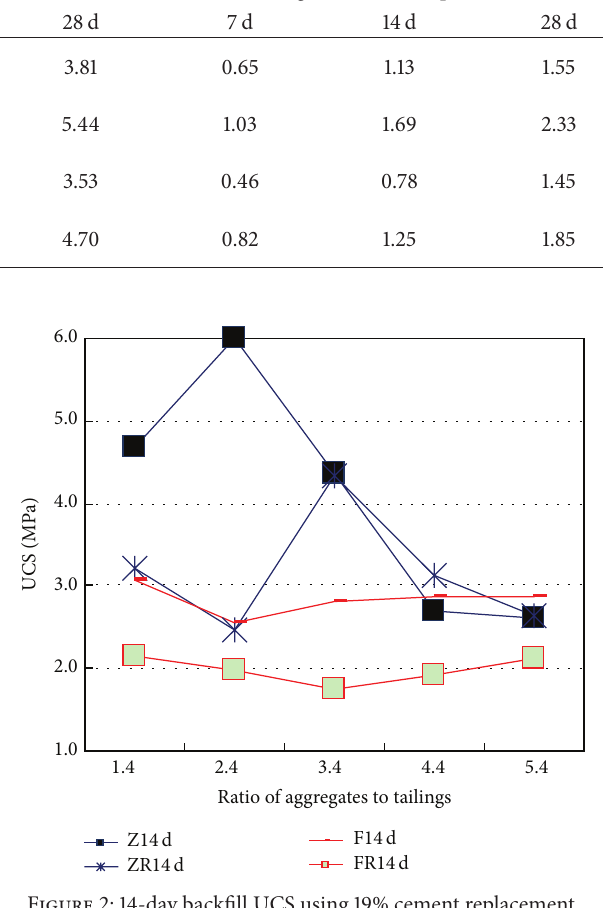
Figure 1: 7-day backfill UCS using 19% cement replacement. Figure 2: 14-day backfill UCS using 19% cement